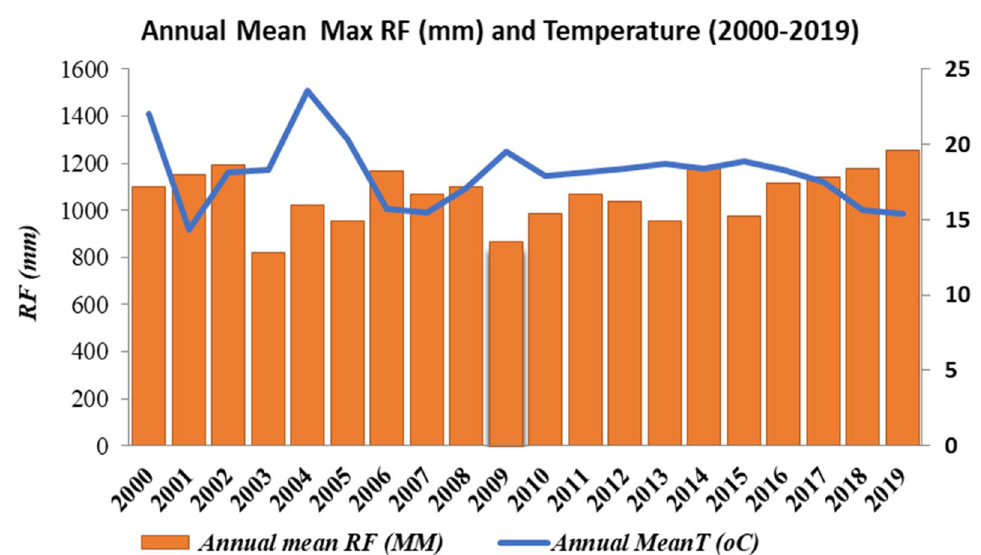
Fig. 2 Mean annual rainfall (mm) and maximum and minimum temperatures T °C